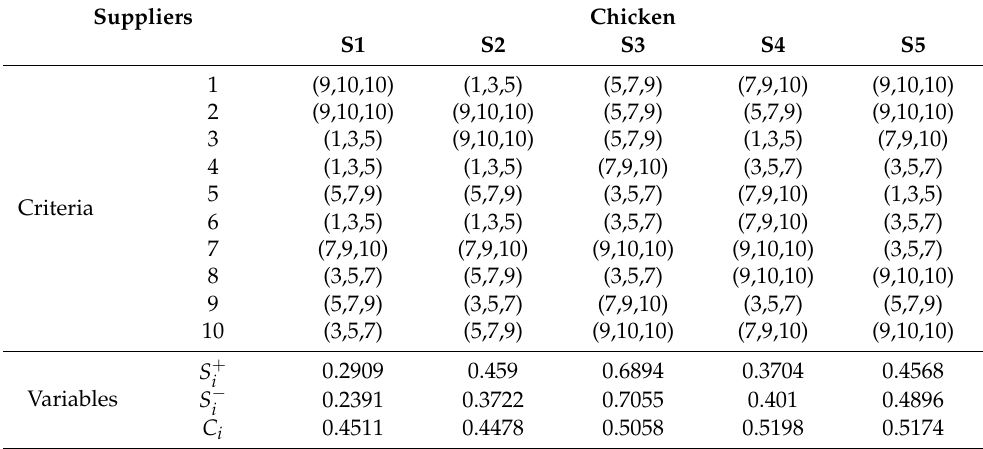
Table A9. Decision matrix considering suppliers and similarity index for chicken.